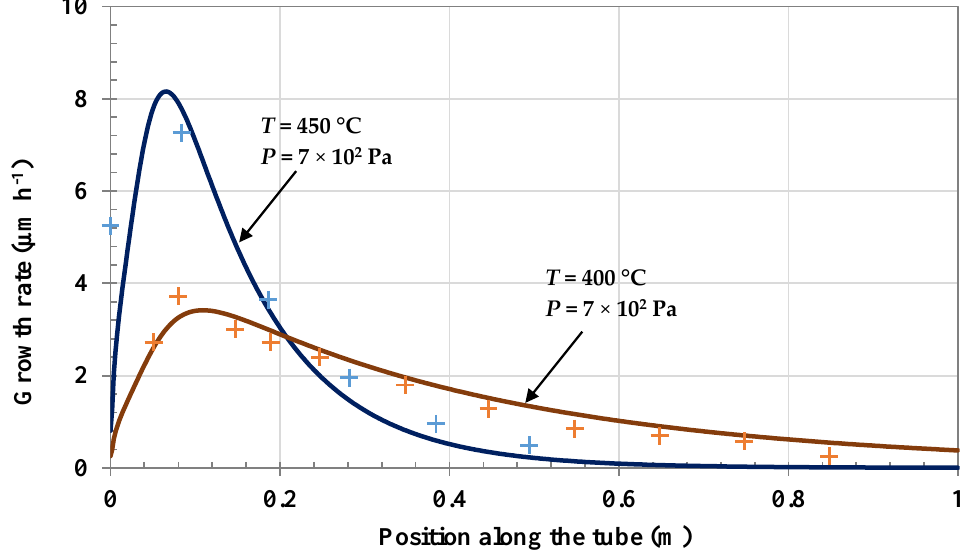
Figure 7. Comparison of calculated ( − ) and measured ( + ) growth rate of chromium carbide along the 1 m reactor walls ( T = 400 and 450 °C, P = 7 × 10 2 Pa, precursor flow rate 4.4 sccm, N 2 flow rate 500 sccm).